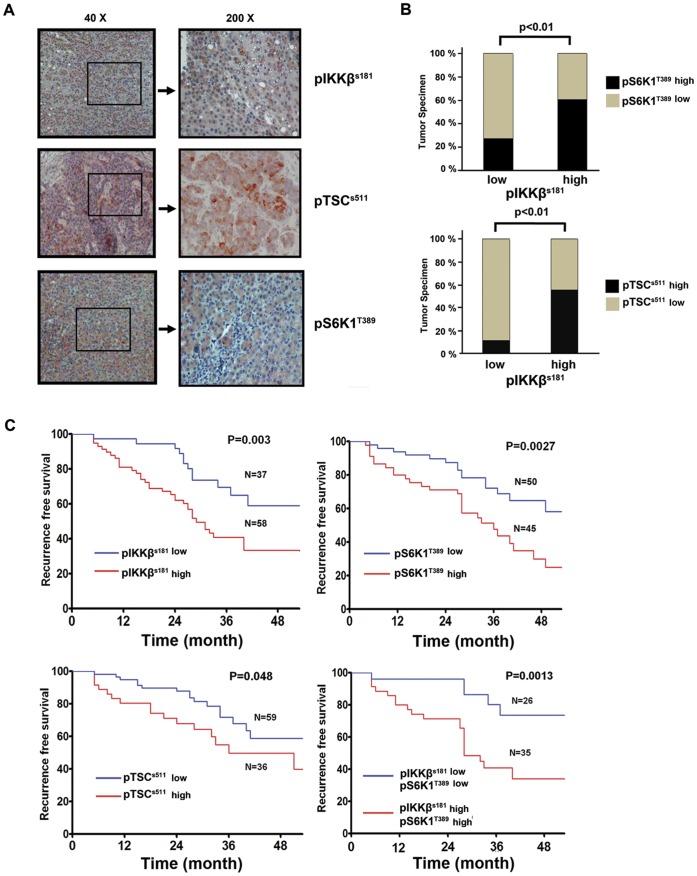
Positive association between pIKKβ(S181), pTSC1(S511), and pS6K1(T389) in HBV-associated human HCC specimens.(A). Immunohistochemistry analysis of pIKKβ (S181), pTSC1(S511) and pS6K1(T389) in tumor tissues of 95 human HBV-associated HCC specimens. Results of one representative specimens stained by specific antibodies are shown. (B). Upper graph shows percentages of specimens with low or high pIKKβ (S181) expression in which pS6K1 (T389) expression was high or was not observed (low). Lower graph shows percentages of specimens with low or high pIKKβ (S181) expression in which pTSC1 (S511) expression was high or was not observed (low). Positive correlations was noted between pIKKβ (S181) and pS6K1 (T389) (*P<0.01) and between pIKKβ (S181) and pTSC1 (S511) (*P<0.01). (C) The Kaplan-Meier disease-free survival curves show that expression of pIKKβ (S181) (p = 0.003), pTSC1 (S511) (p = 0.048), or pS6K1 (T389) (p = 0.0027) is associated with early tumor recurrence. Co-expression of pIKKβ (S181) and pS6K1 (T389) (p = 0.0013) was a better predictor of patients’ recurrence-free time survival in HCC patients who received curative surgery for up to 48-month investigation.